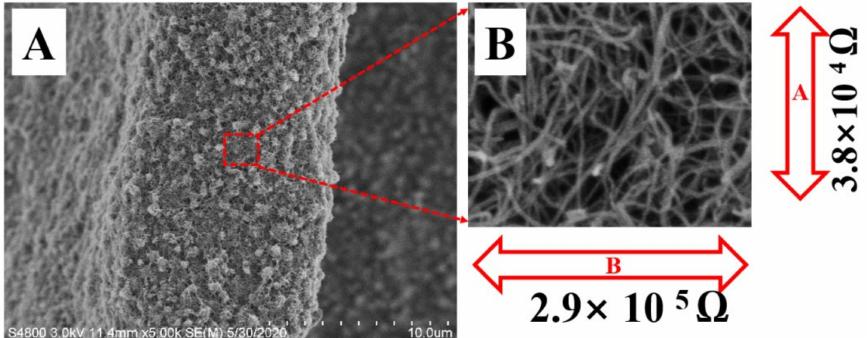
Figure 4. SEM images of one certain wrinkle ( A ) and the corresponding image with higher magnifi- cation ( B ) to show the preferred alignment of CNTs along direction A. The numbers in ( B ) represent the magnitude of electric resistance in the indicated